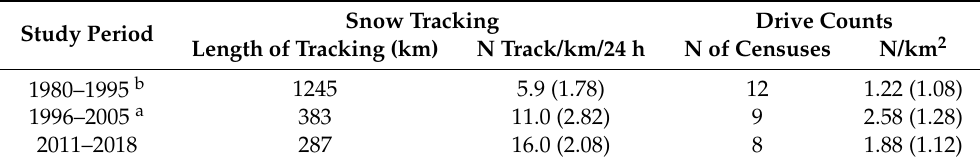
Table 3. Mean ( ± SD) density of snow tracks of the red fox (N tracks/1 km/24 h) and mean ( ± SD) spring density of the red fox based on the drive counts assessment in the study area (field and forest mosaic, Central Poland) in the three periods: 1980–1995, 1996–2005 [18], 2011–2018 (this study). b—before rabies vaccination; a—after rabies vaccination. Snow tracking was performed both in the forest and in open fields. Driving census was completed only in forests. Snow Tracking Drive Counts Study Period Length of Tracking (km) N Track/km/24 h N of Censuses N/km 2